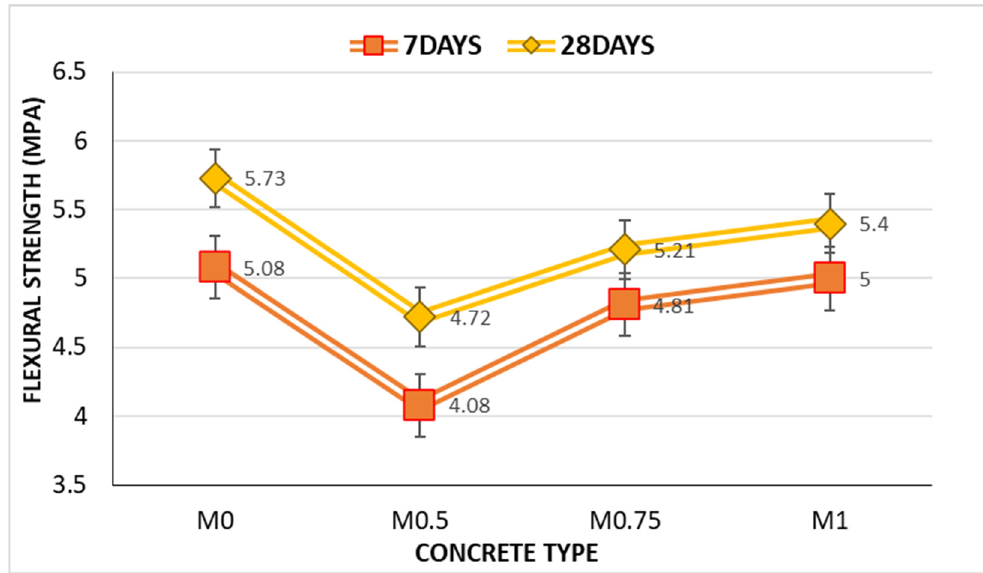
Figure 15. Flexural strength value of different types of SCC mixes.